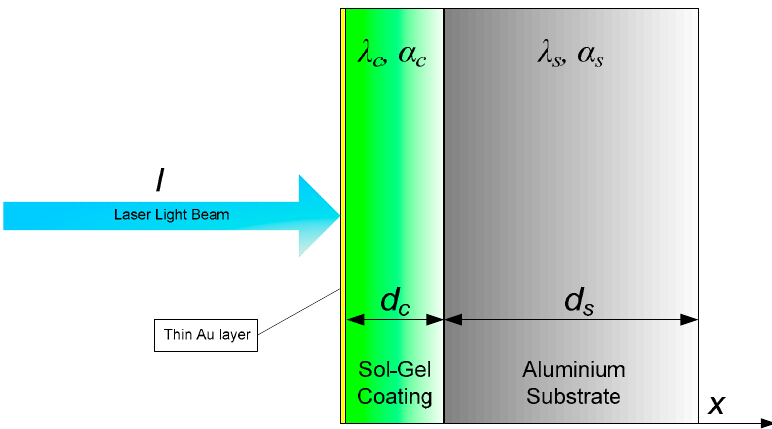
Figure 3. Simplified schematic of the investigated sample.